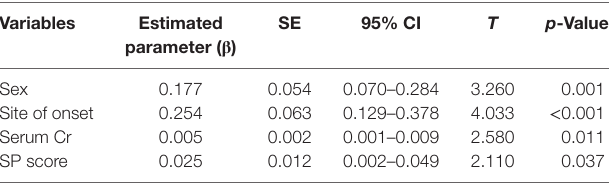
Table 2 | Factors significantly correlated with log CK in ALS patients by multivariate linear regression analysis.